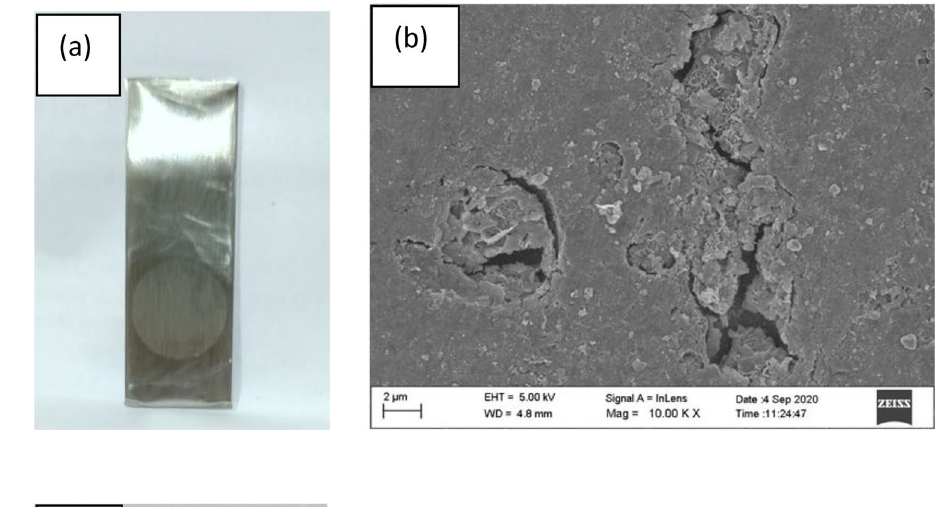
Fig. 5 a Photograph and b SEM micrograph of GO coated 304SS after prolonged corro- sion